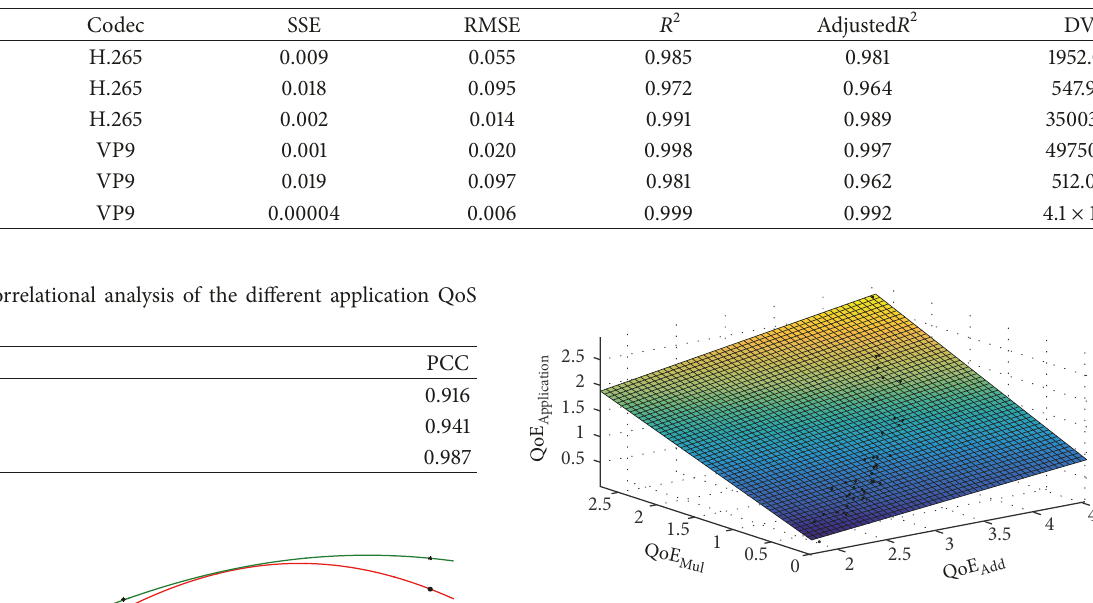
Table 19: Model fitting statistics for application factors.